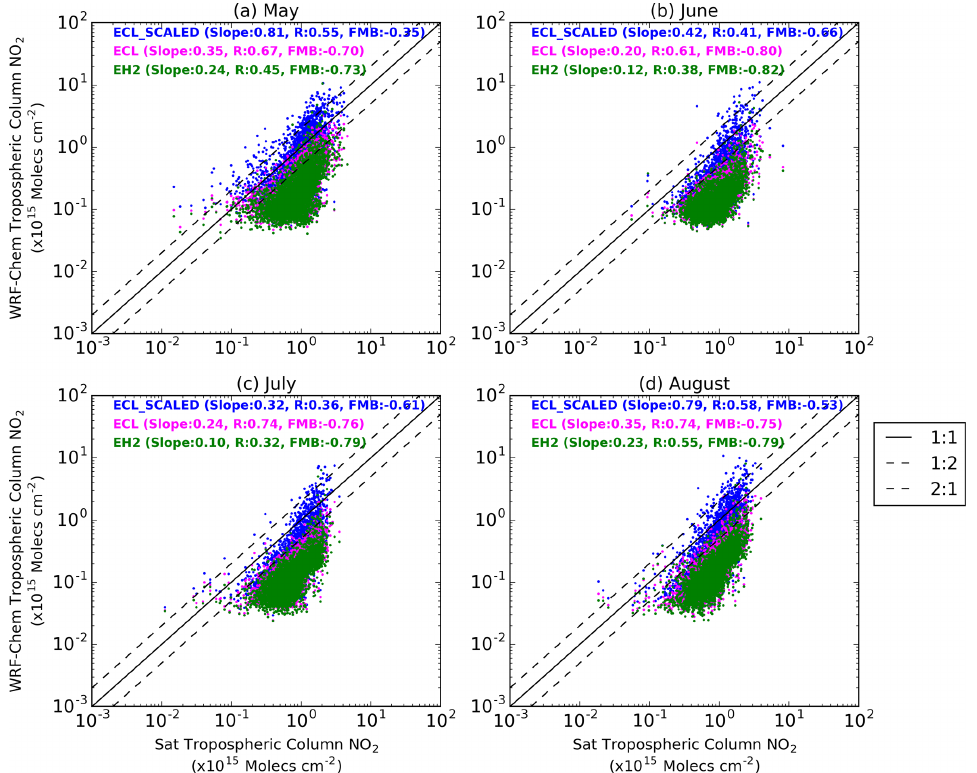
Figure 4. WRF-Chem-simulated versus OMI tropospheric column NO 2 using ECL (magenta), EH2 (blue) and ECL_SCALED anthropogenic emissions for May (a) , June (b) , July (c) and August (d) . All plots show total domain below 65 ◦ N. Slope, correlation coefficient ( R ) and fractional mean bias (FMB) are shown in each panel. Table 2. Root-mean-squared error (RMSE) values for monthly simulated tropospheric column NO 2 in urban and background regions within western Siberia when compared with OMI values, for each of the model simulations using EH2, ECL and ECL_SCALED emissions. Month Urban Background Urban Background Urban